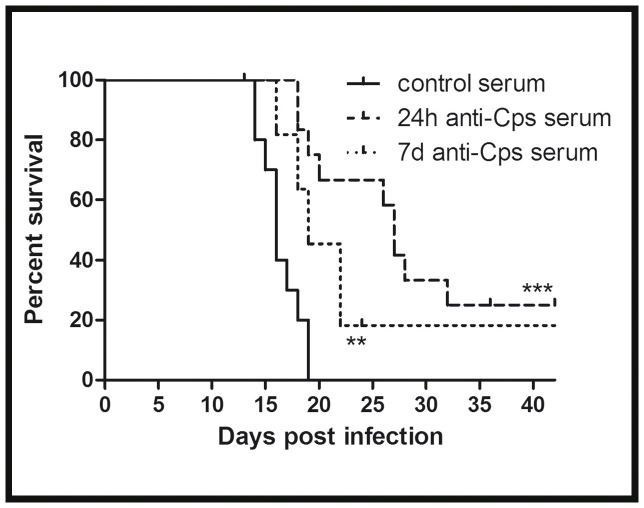
Figure
10. Anti-
C. psittaci
 serum protects C3−/− mice efficiently when transfer is performed within 1 day p.i. To raise a high-titer immune serum, WT mice were infected with 4×104 IFU C. psittaci and re-infected after 28 days. After 56 days, serum of the clinically recovered mice was collected and heat inactivated to eliminate functional donor C3. C3−/− mice were infected with 4,000 IFU of C. psittaci and received anti-C. psittaci serum either 1 day (dashed line) or 7 days (dotted line) afterwards. Alternatively, heat-inactivated control serum from non-infected mice was transferred to the knockout mice on day 1 p.i. (solid line). Survival rates were determined for up to 42 days post-infection. * indicates significant differences (p<0.05) between mice which received the anti-C. psittaci serum as compared to the mice which received control serum, and ** or *** p<0.01 and p<0.001, respectively.